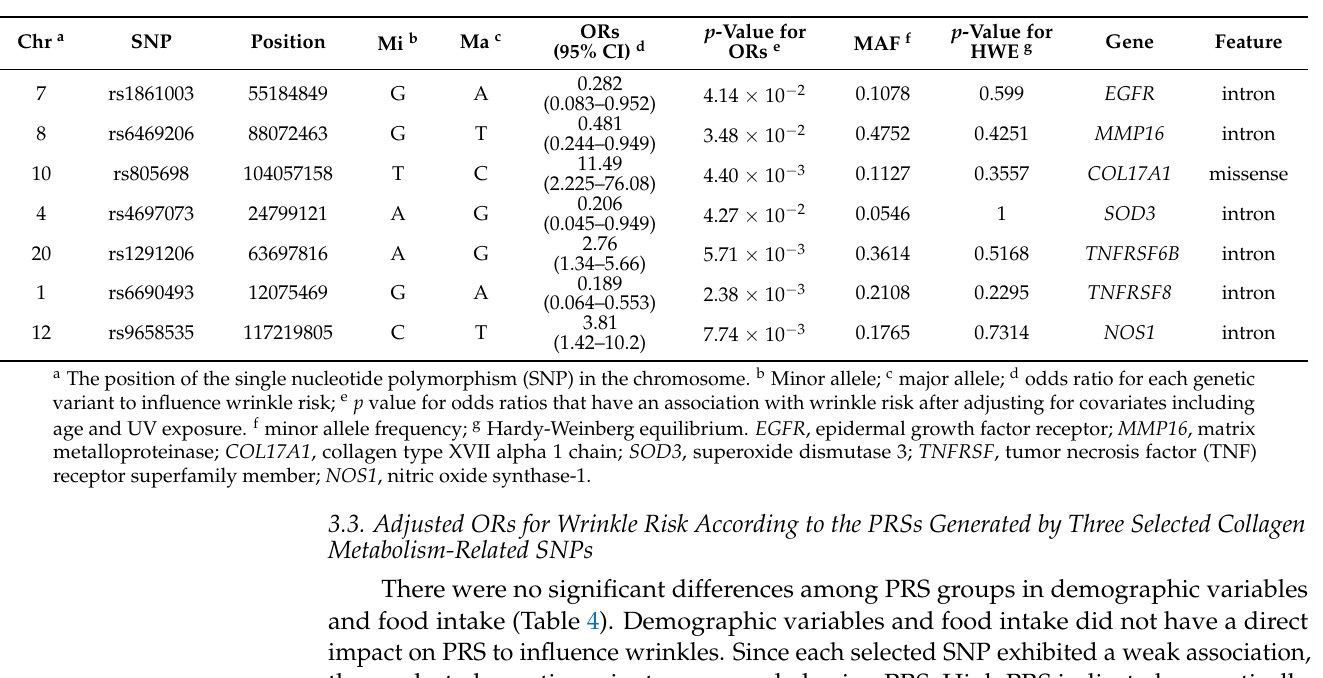
Table 3. Characteristics of genetic variants that influence skin-wrinkle risk selected by genome-wide association study. Chr a SNP